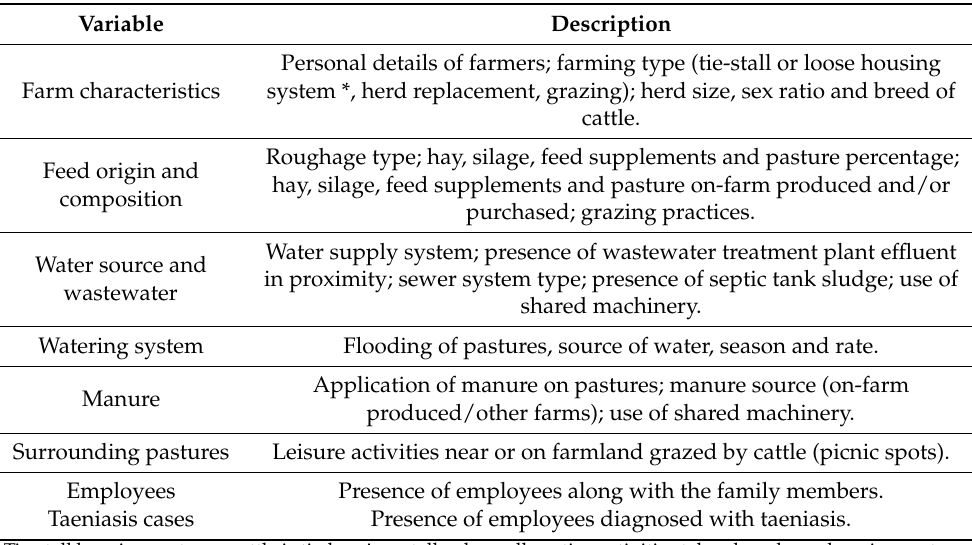
Table 1. Description of variables included in the risk analysis for BC in North-West Italy between 2005 and 2011 and between 2014 and 2020. Variable